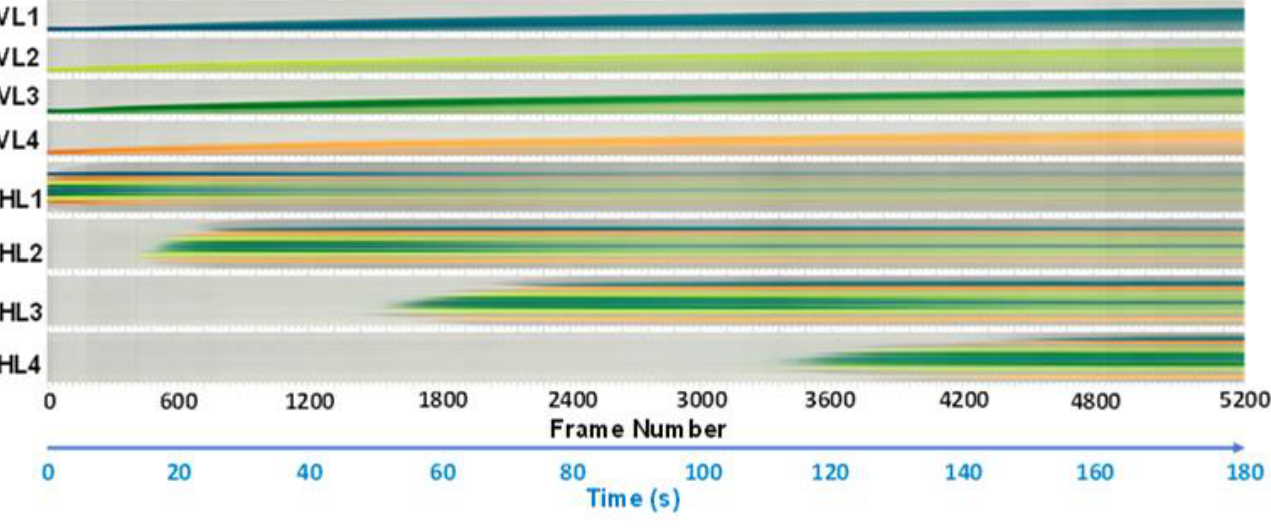
Figure 6. Exported time cross-section image across the eight-line segments (for vertical line seg- ments VL1~VL4 and horizontal line segments HL1~HL4) for 0–180 s (30 fps × 180 s = 5400 frames) using PicMan.